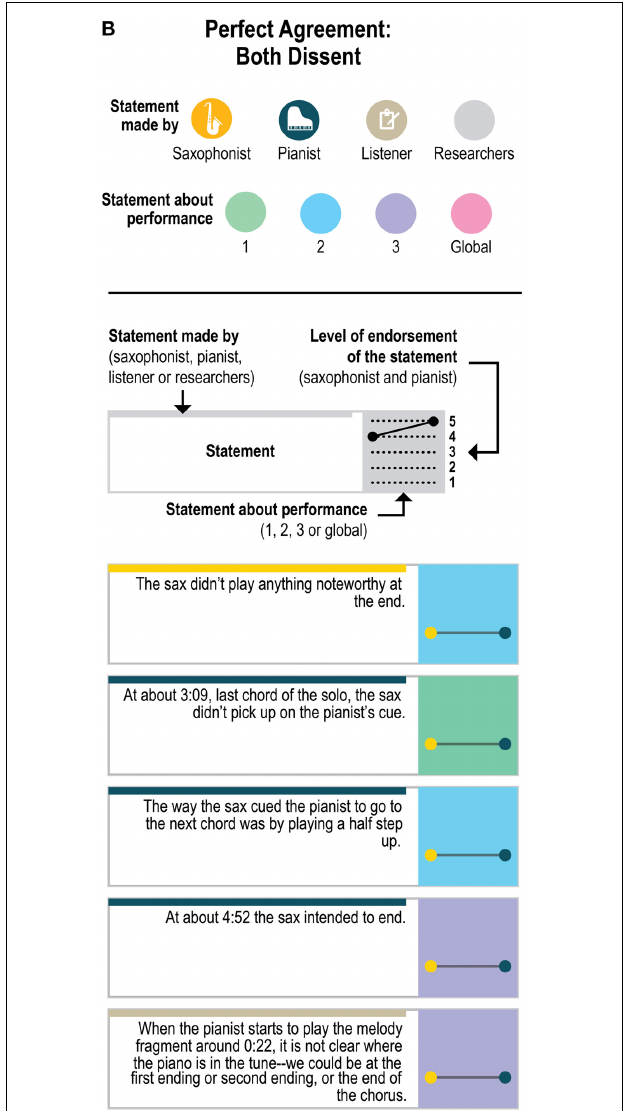
FIGURE 5B | Statements with perfect agreement where both players